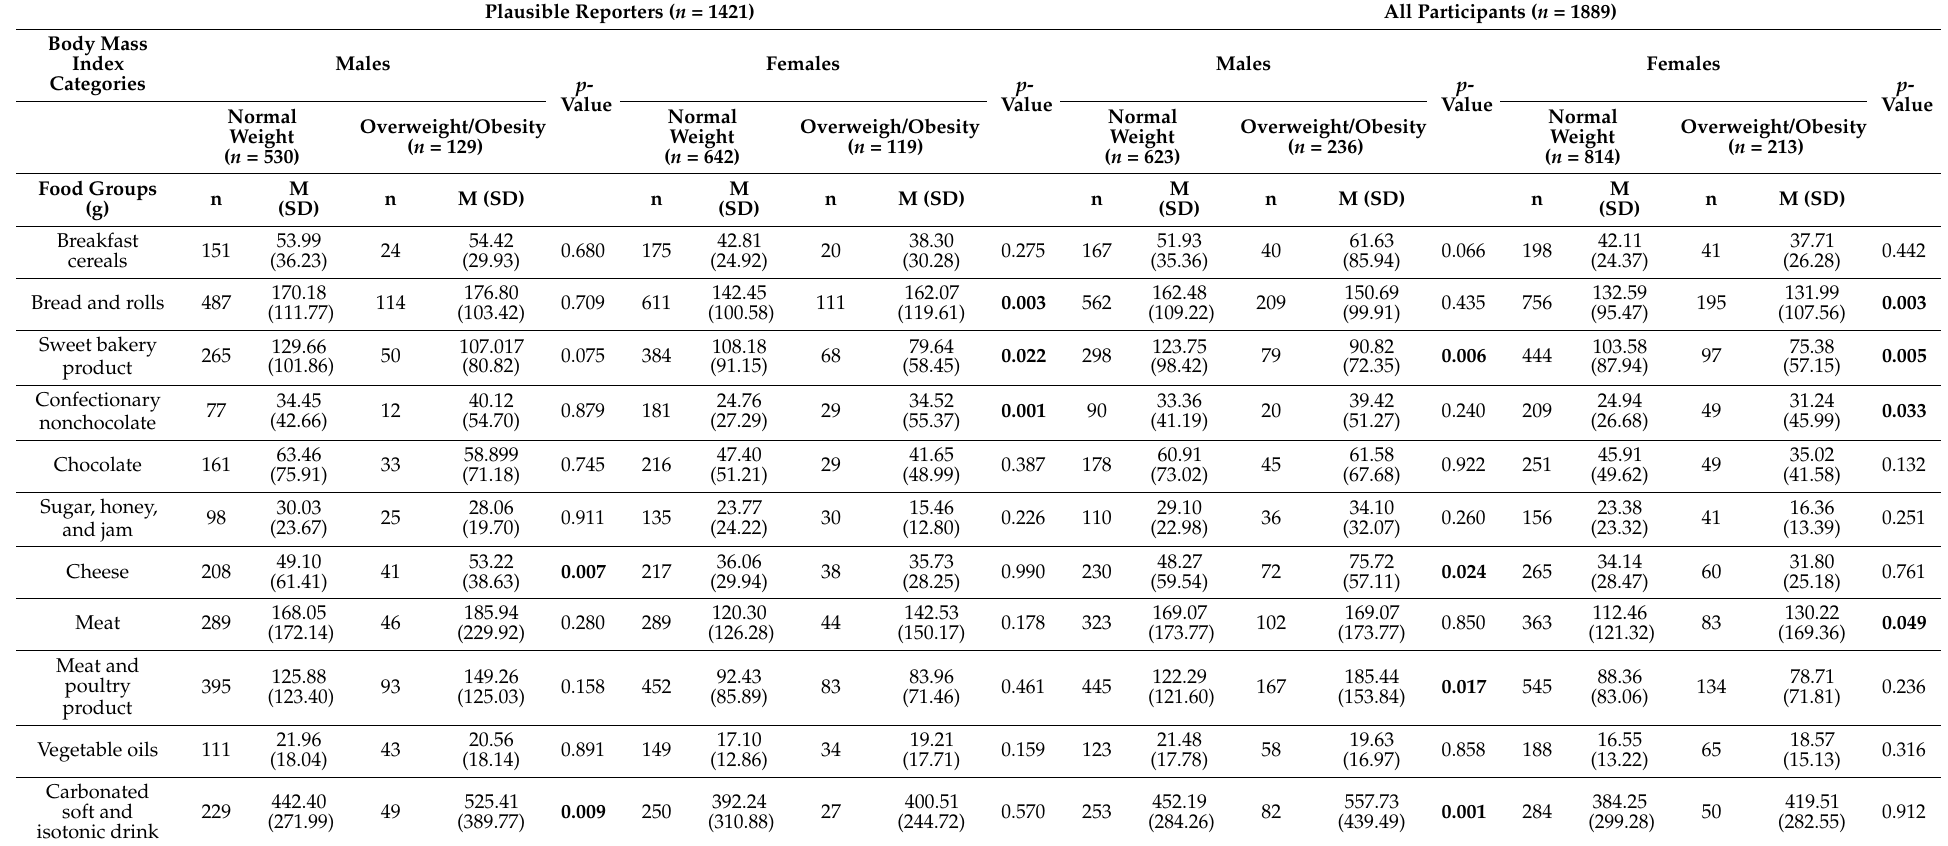
Table 2. Mean portion size of energy-dense (ED) foods by BMI status in both genders, for consumers of different food categories, using t